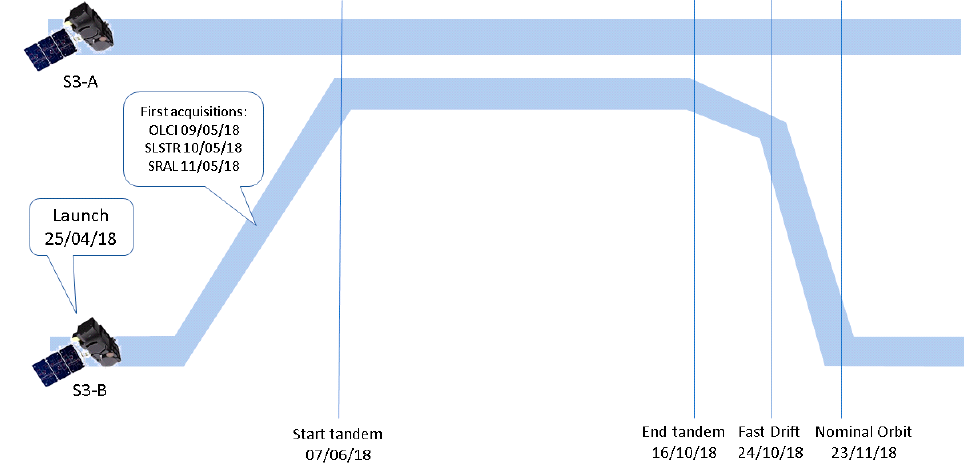
Figure 1. The main phases of the Sentinel-3B tandem operations.